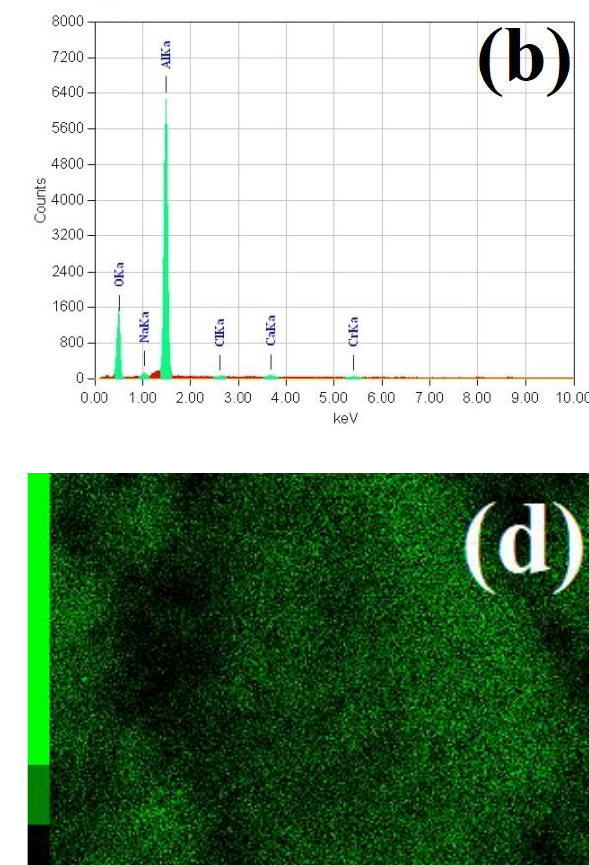
Table 6. Comparison with standard requirements of Al 2 O 3 obtained by calcination of ACH at 800 °C for 60 min followed by water leaching and the same calcination, wt.%.